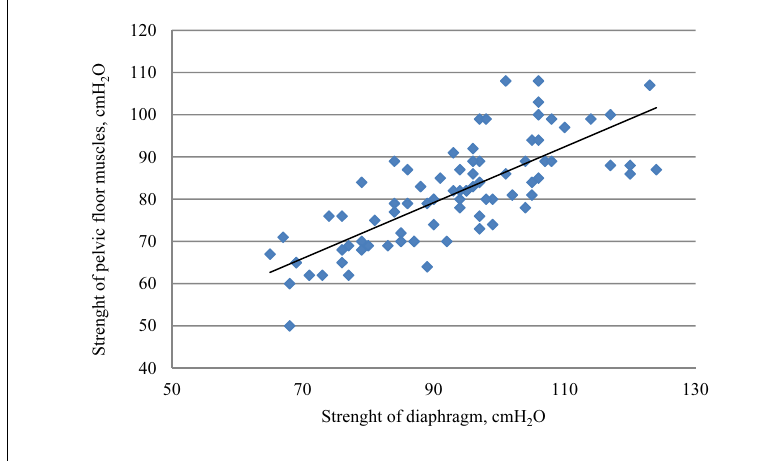
Note. r = 0.79, p < 0.001.